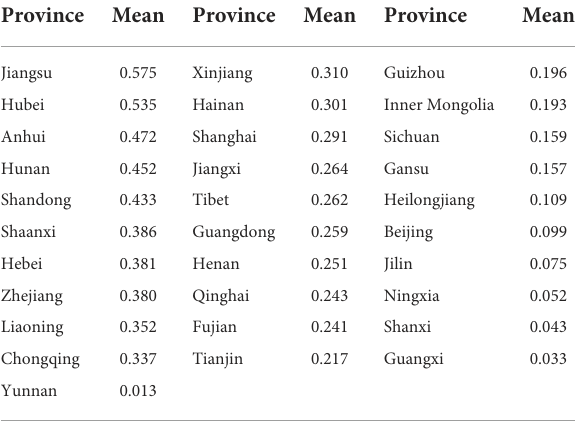
TABLE 3 Average environmental pollution in each city and province. Province